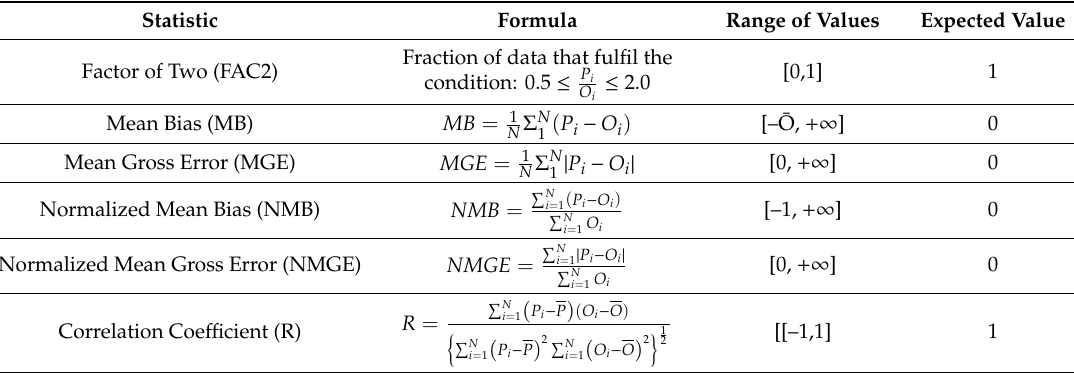
Table 1. Definitions of error statistics used in the study. O is for observed values and P is for predicted